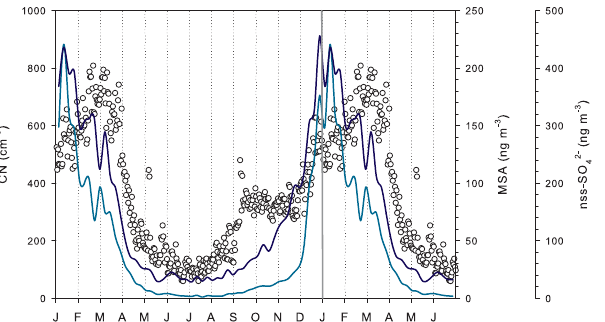
Fig. 3. Mean annual cycle of the CP concentrations (circles, based on daily mean values for the period 1991 through 2009), nss-SO 2 − and MS (solid blue and cyan line, respectively, both based on weekly samples taken during the same period). The graph com- prises 18 months starting from January to show the summer maxima without cease.